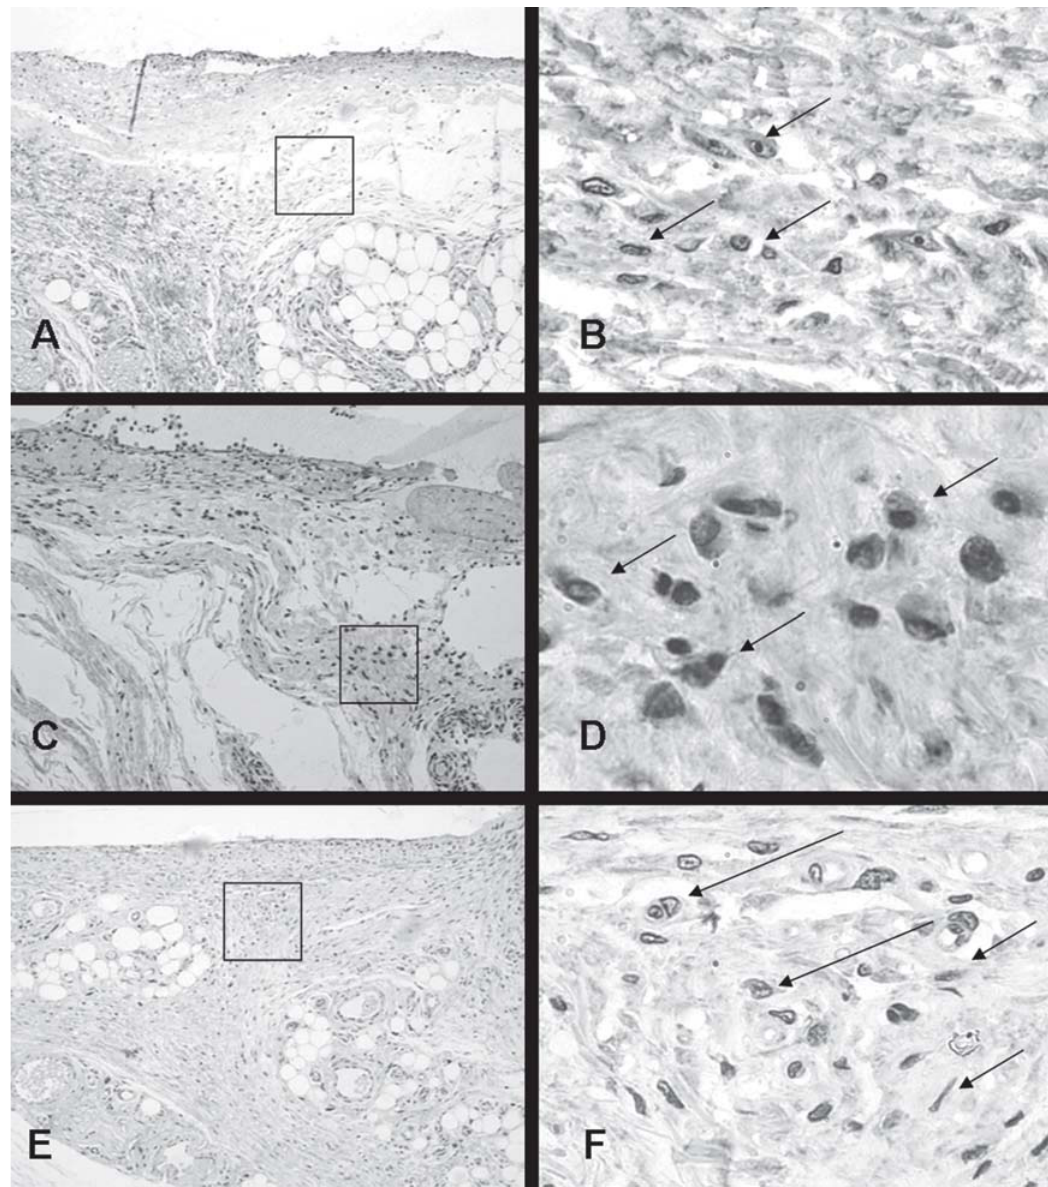
FIGURE 4- Rat subcutaneous tissue reaction to the empty tube. A moderate reaction without the organization of fibrous capsule was observed on the 3rd day - HE 50x (A). Greater magnification showing that the tissue was mainly infiltrated with chronic cells (arrows) - HE 400x (B). The intensity of the reaction was milder and the fibrous capsule was still not formed on the 7th day - HE 50x (C). Greater magnification showing chronic cells (arrows) - HE 400x (D). On the 30th day, a more organized tissue was observed but the fibrous capsule was not completely organized (E). Greater magnification showing a predominance of connective fibers, fibroblasts (small arrows) and chronic cells (large arrows) - HE 400x